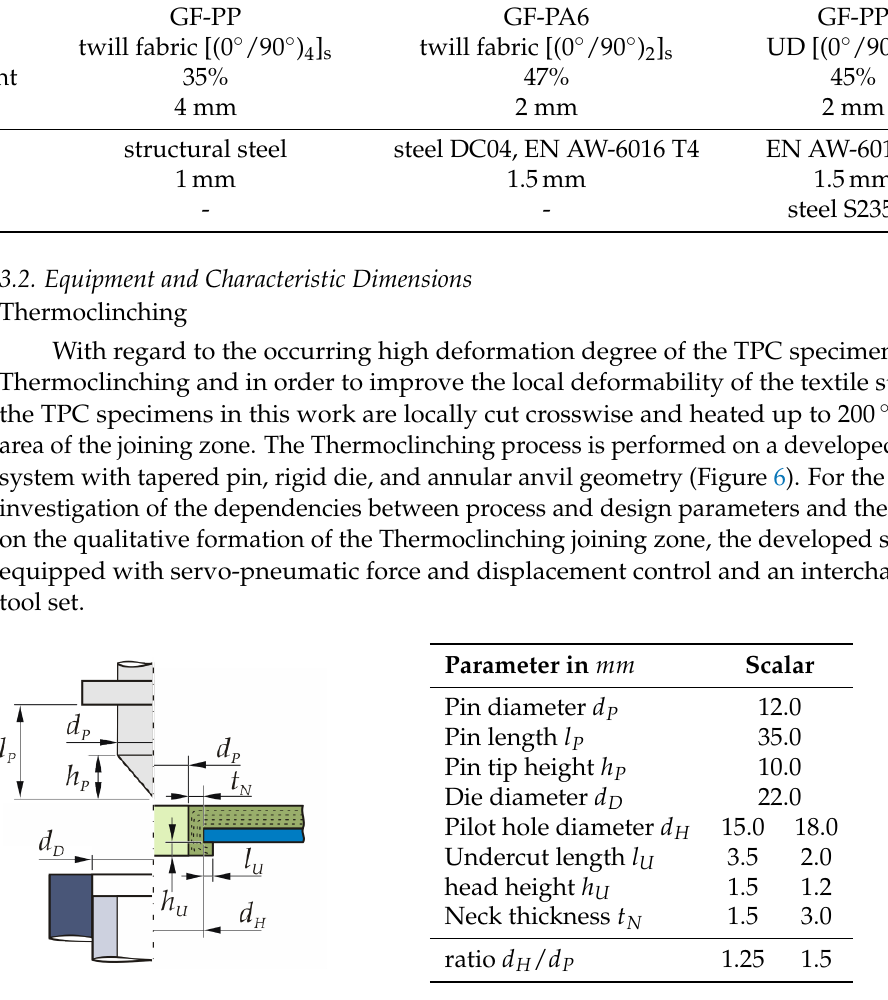
Figure 6. Schematic illustration of Thermoclinching joining zone and tools with parameters.